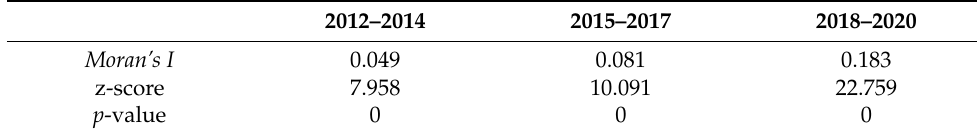
Table 4. Moran’s I index during three time periods.